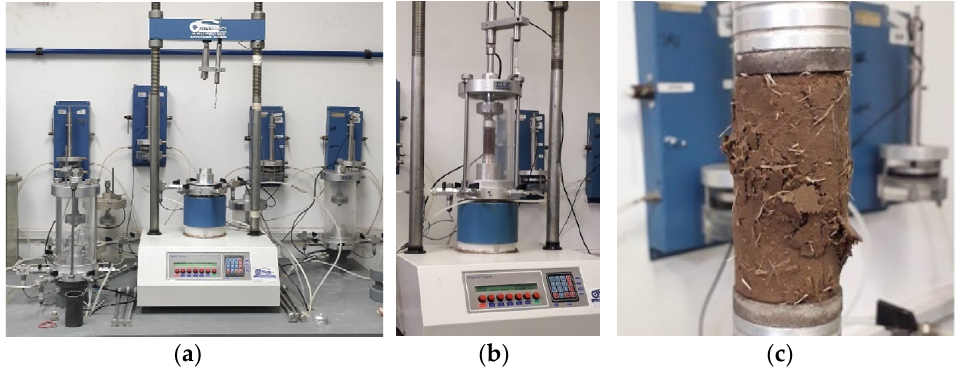
Figure 6. ( a ) ELE Compression Frame, ( b ) Sample during test, ( c ) Sample after the test.